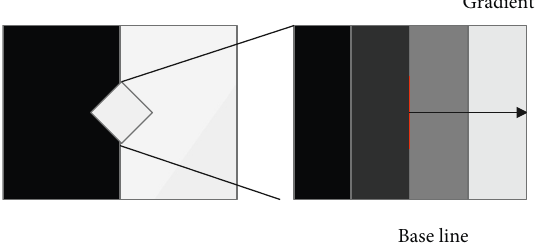
Figure 2: Gradient and gradient angle.